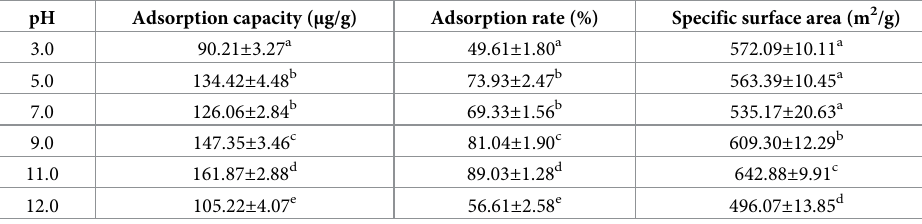
Table 3. Effect of pH on the specific surface area and adsorption to AFB1 of